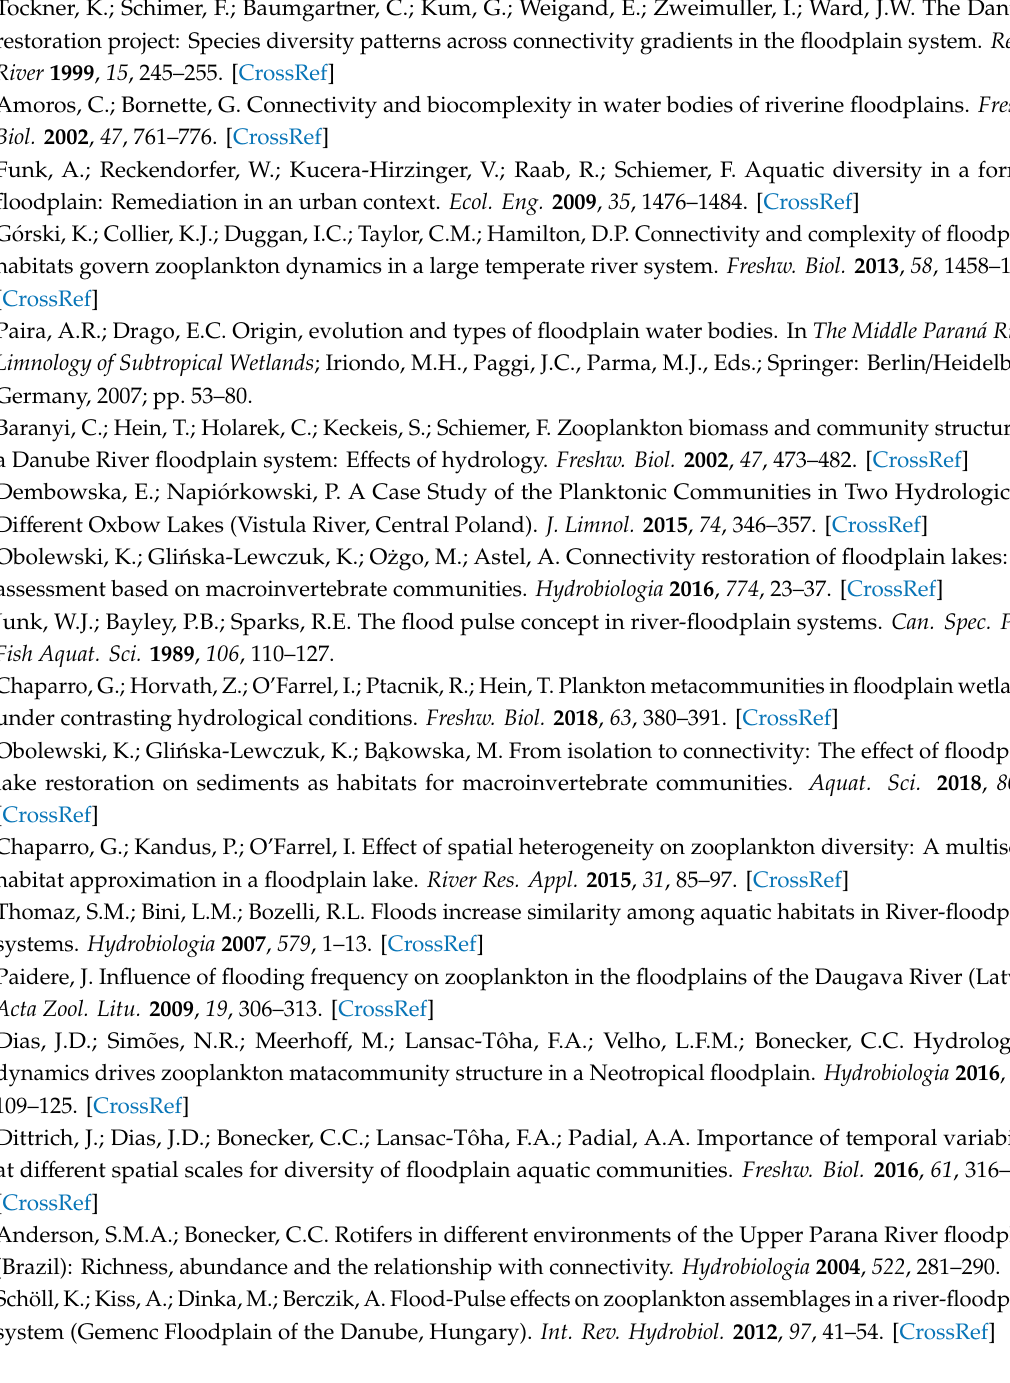
Table S1: List of zooplankton taxa at studied floodplain lakes and at the Vistula